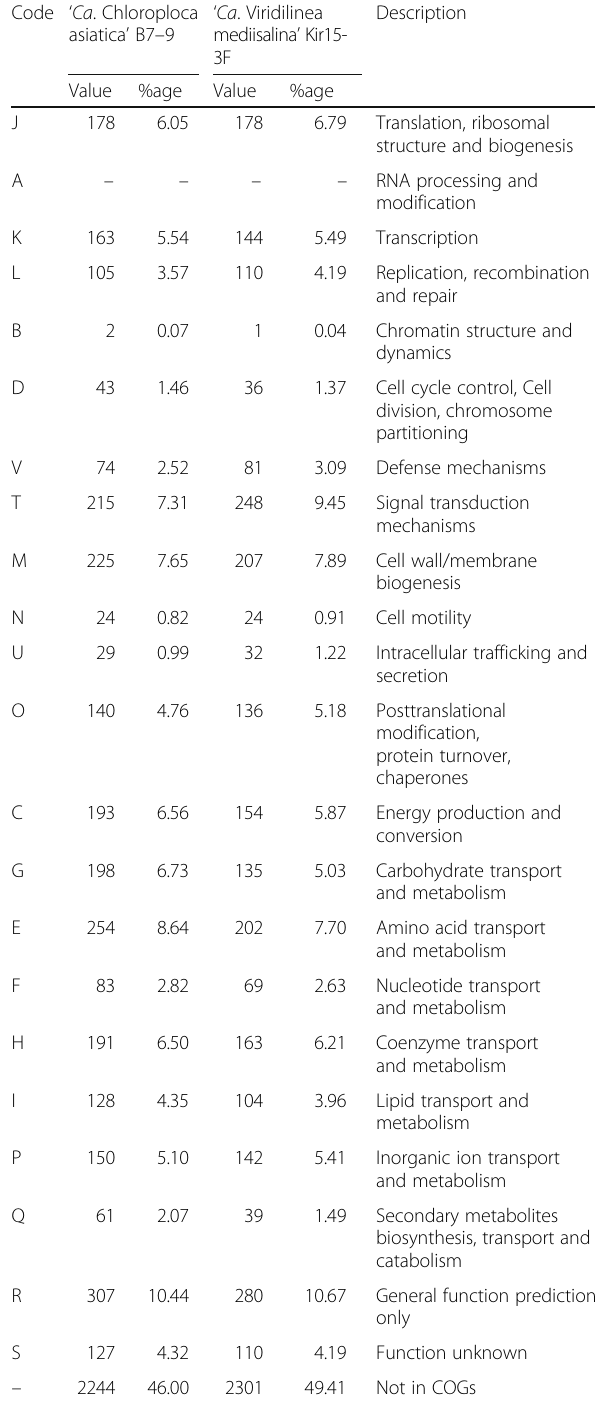
Table 5 Number of genes associated with general